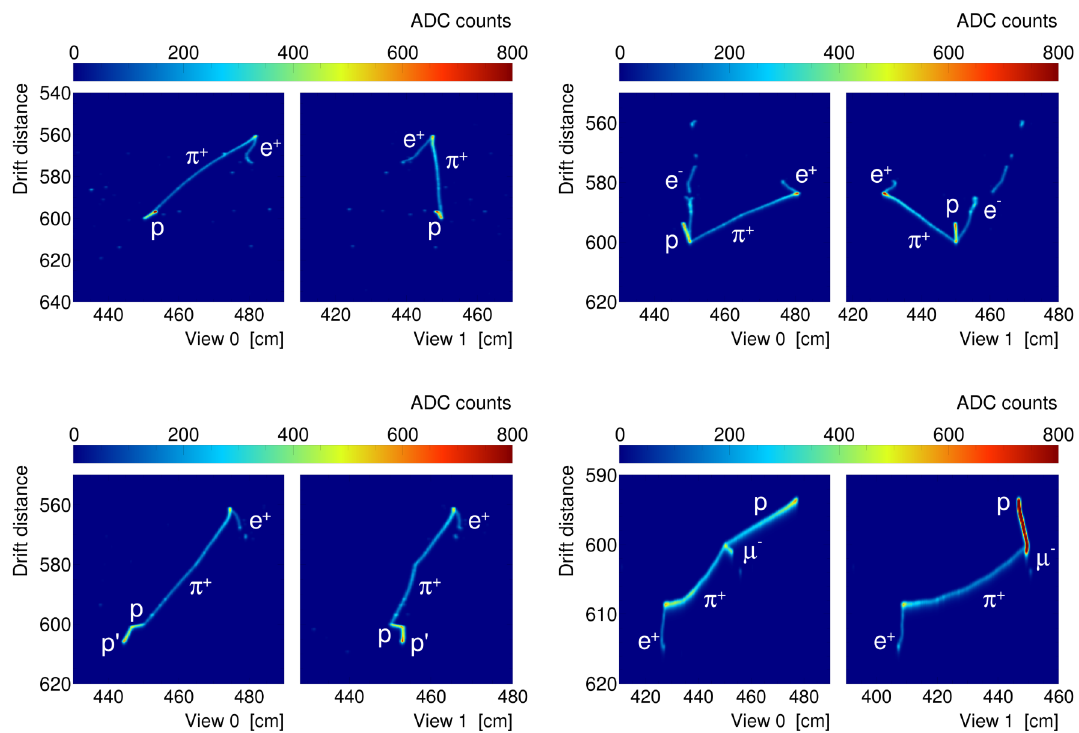
Figure 8 . Event displays of persistent background events in the reference sample. In all events, the proton is misidentified as signal K + and the π + is mistaken for the µ + from K + decay at rest. The top left event justifies cut 4.2.5 as the proton shadows the first part of the π + track in the best view. The top right event fails cut 4.3 as it has two showering particles and the two events at the bottom fail cut 4.4 since there is an additional track present, with the scattered proton in the bottom left event being reconstructed as two separate tracks.